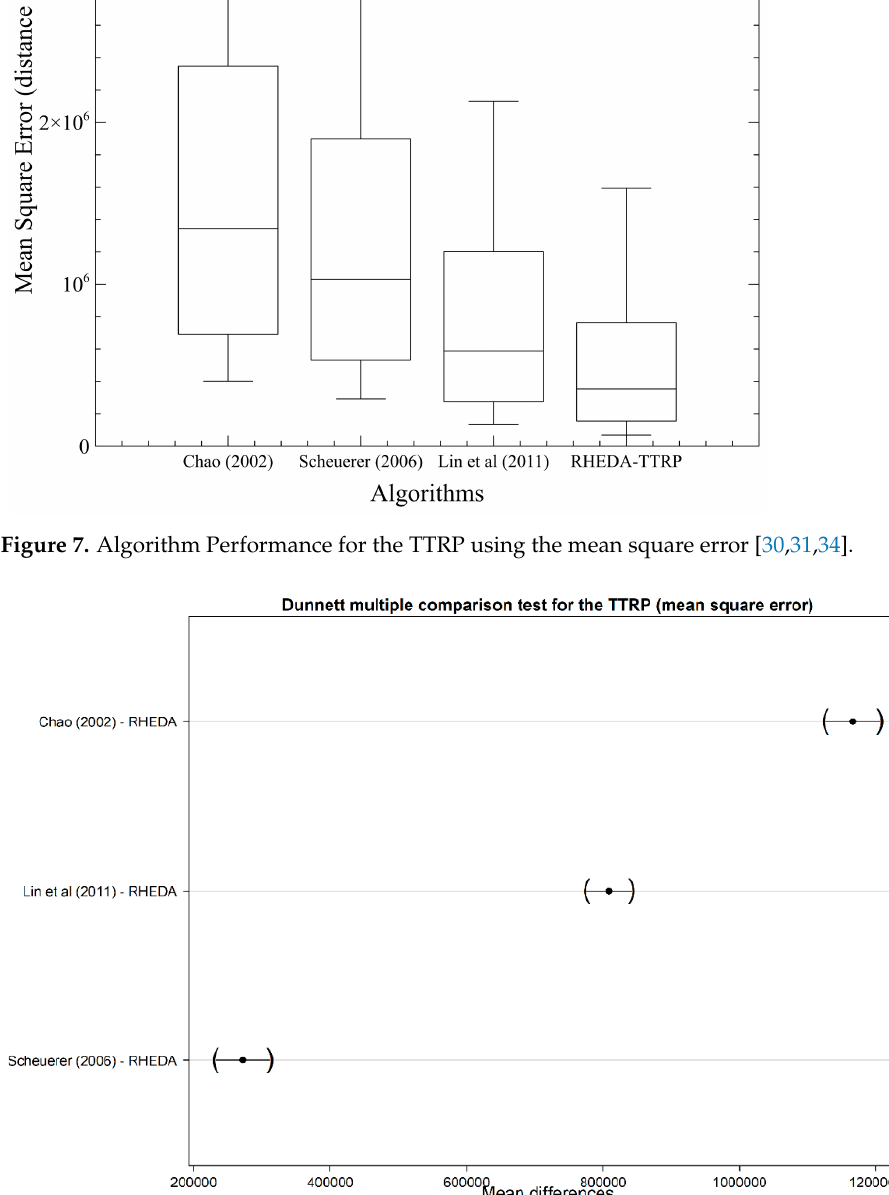
Figure 9. Algorithm Performance for the TTRP using the relative percentage increase [30,31,34]. Figure 10 indicates a last Dunnett test; there is a statistically significant difference between all the recent algorithms and the RHEDA-TTRP scheme. Based on Equation (5), The RHEDA-TTRP scheme outperforms all the recent algorithms for the TTRP.